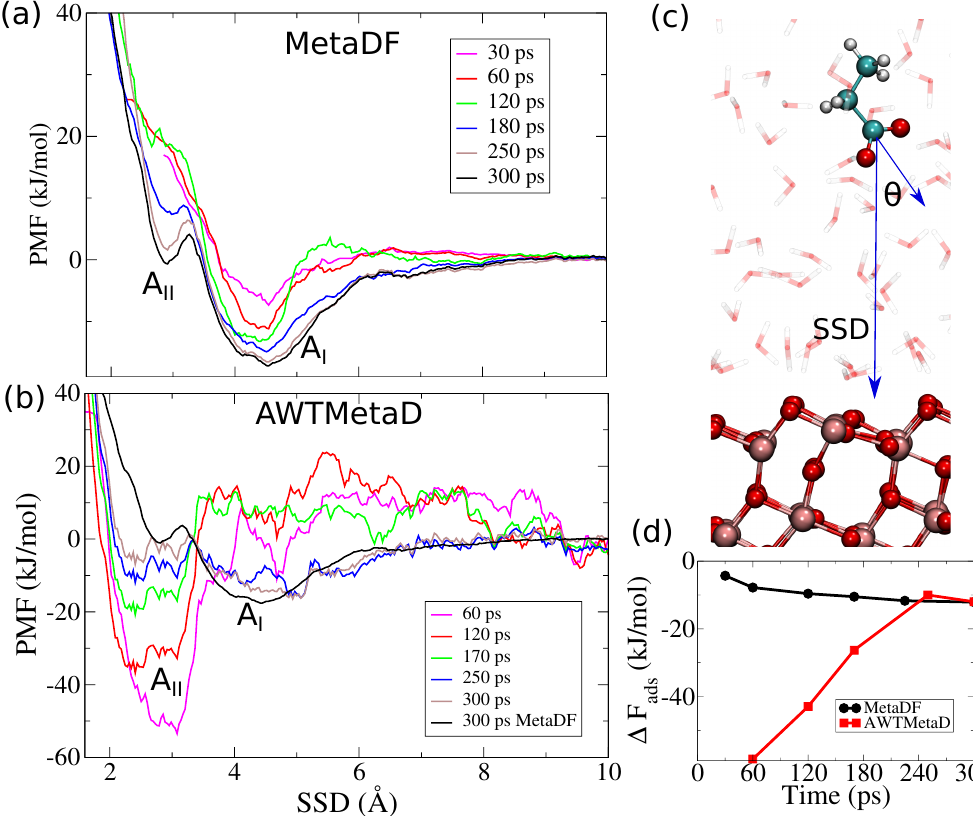
Figure 5. Potentials of mean force (PMF) along the surface separation distance (SSD)for Aspartate on anatase (101) calculated with ( a ) MetaDF and ( b ) AWTMetaD. The two minima correspond to adsorption modes A I (indirect surface contact) and A II (direct surface contact). Adsorption mode A I converges within an error of 3.5kJmol − 1 in 180 ps with MetaDF (as estimated from the force variance [57] and the convergence profile ( d )), but fails to converge after 300 ps with AWTMetaD. ( c ) A representation of the two CVs used to sample the free energy landscape. θ is the angle between the normal vector to the TiO 2 surface and the vector C OO − − C fn . ( d ) ∆ F ads as function of time. MetaDF converges asymptotically after 180 ps but AWTMetaD has still not converged after 300 ps.